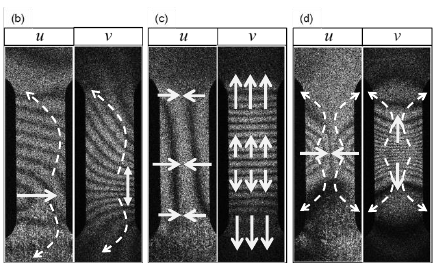
Figure 5. Interpretation of fringe pattern evolution. (b–d) here match (b–d) in Figure 3 and the texts under Figure 3.